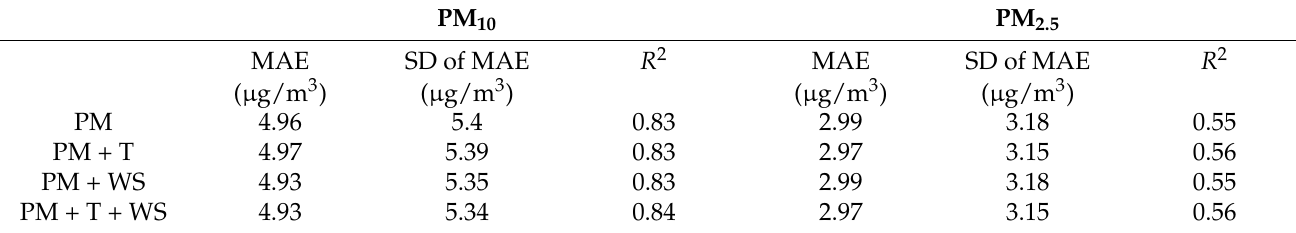
Table 6. MAE, SD of MAE and R 2 values that correspond to the MLR methodology, for PM 10 and PM 2.5 and the four different input